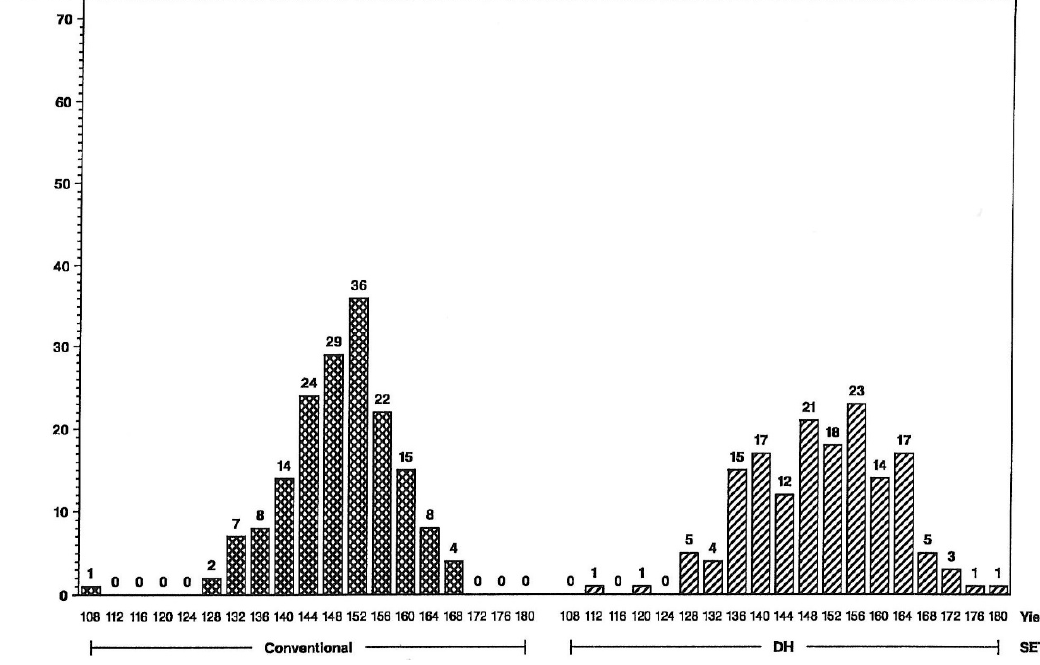
Figure 2. Frequency distributions for maize hybrid grain yields in bushels per acre (on x -axis) using the U inbred tester, conventional S2 line-hybrids on the left and DH line-hybrids on the right. Numbers of hybrids are above the bars.